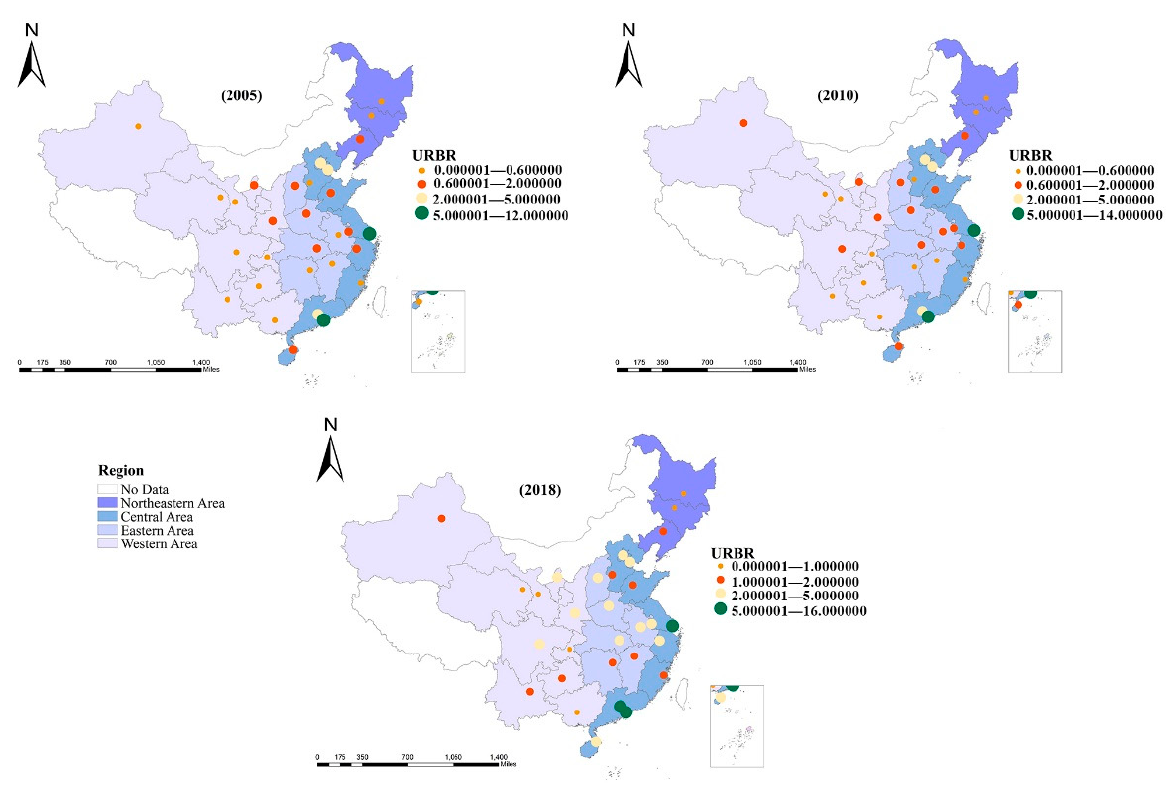
Figure 3. Urbanization levels of China’s 30 large and medium-sized cities for the selected years.